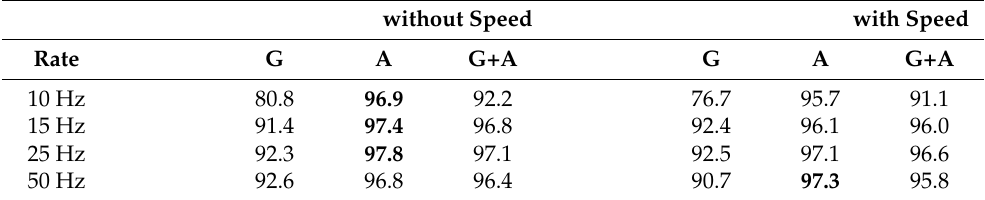
Table 7. Classification accuracy on the test set for different signal combinations and rates for 1.5 s segments and a rotation to the horse-frame with the best performance for each rate in bold. The num- bers reported are the median micro-averaged accuracy over 9 random seeds (a different random seed was used each time the model was trained and evaluated on the test set). G stands for Gyroscope only, A for Accelerometer only and G+A for Gyroscope and Accelerometer. without Speed with Speed Rate G A G+A G A G+A 10 Hz 80.8 96.9 92.2 76.7 95.7 91.1 15 Hz 91.4